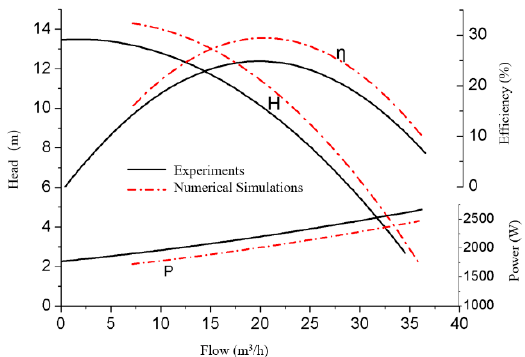
Figure 11. Comparison of simulation prediction and test results.